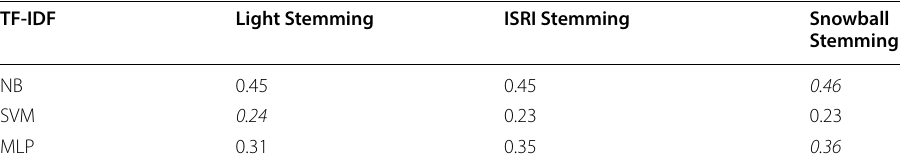
The italic values indicate the highest accuracy (best one)